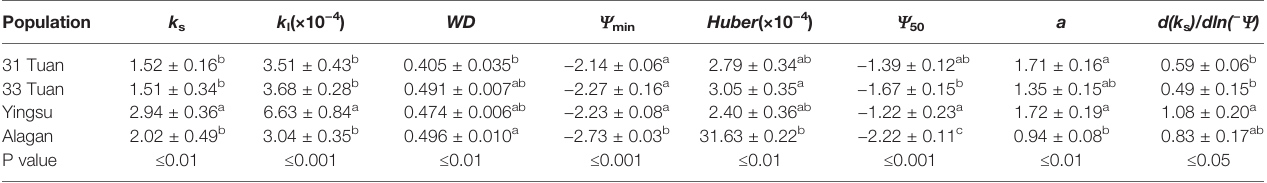
TABLE 3 | Means and the standard error of the mean for k s , k l , WD , Y min , Huber value, Y 50 , d( k s )/dln( − Y ), and a at the four sites.